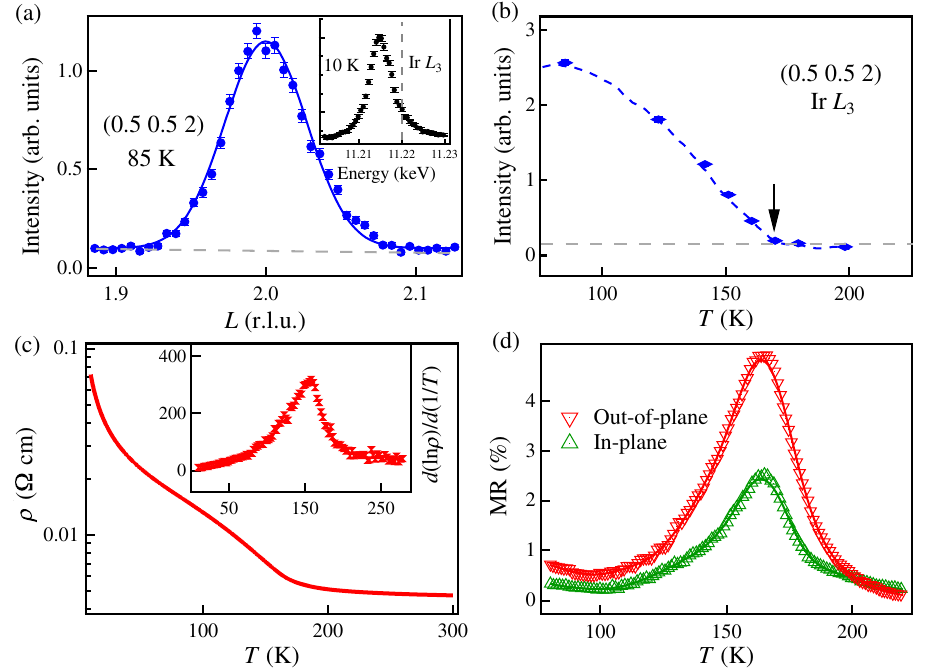
FIG. 2. Magnetic structure and magnetoresistance effect. (a) L scan across the (0.5 0.5 2) magnetic peak. Dashed line represents the background signal. Error bar represents statistical error. Inset shows the energy profile at 10 K, where a vertical dashed line indicates the Ir- L 3 absorption edge. (b) Integrated intensity of magnetic peak versus temperature. T is denoted by a black arrow. (c) Temperature N dependence of in-plane resistivity. Inset shows the relation between d ð ln ρ Þ =d ð 1 =T Þ and temperature. (d) Temperature-dependent MR measured under an out-of-plane (red) or in-plane (green) 8 T magnetic field.